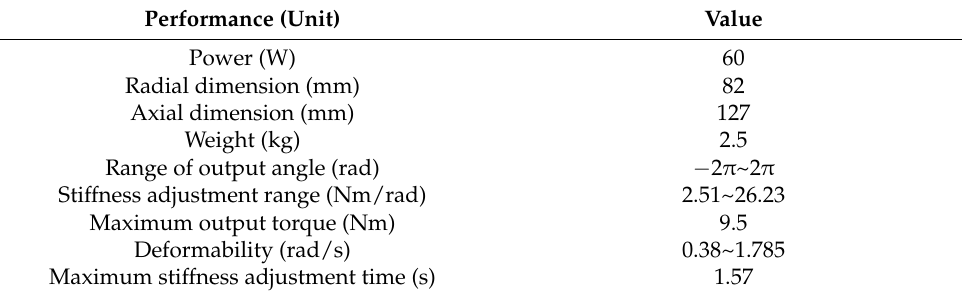
Table 2. Performance of Physical